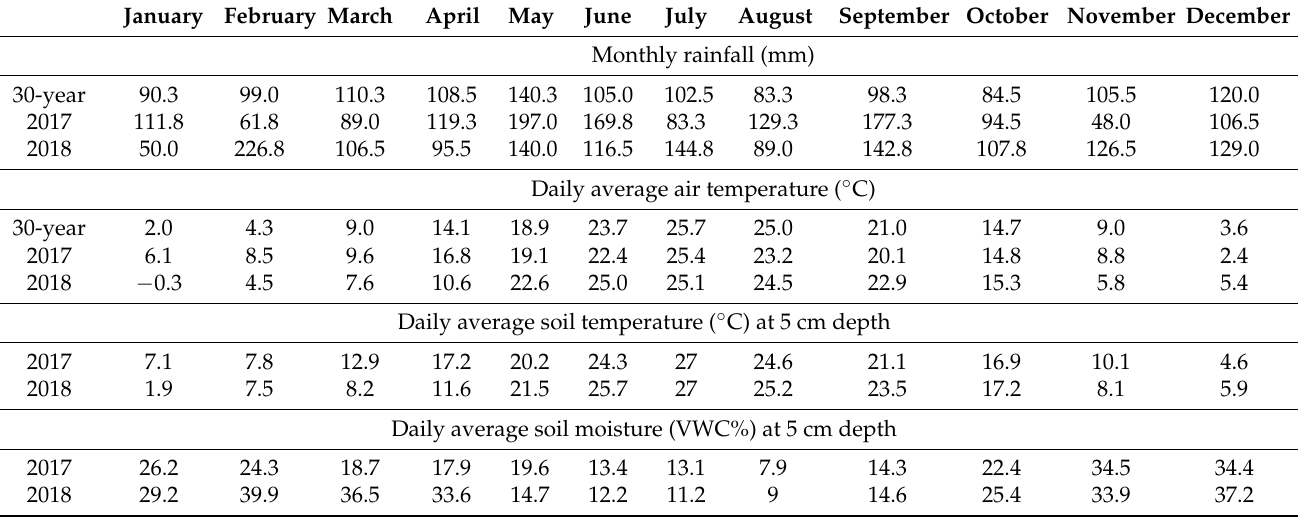
Table 3. Monthly precipitation, average daily air temperature, and soil temperature and soil moisture content (5 cm depth) in 2017 and 2018 with 30-year average of the experimental site presented by